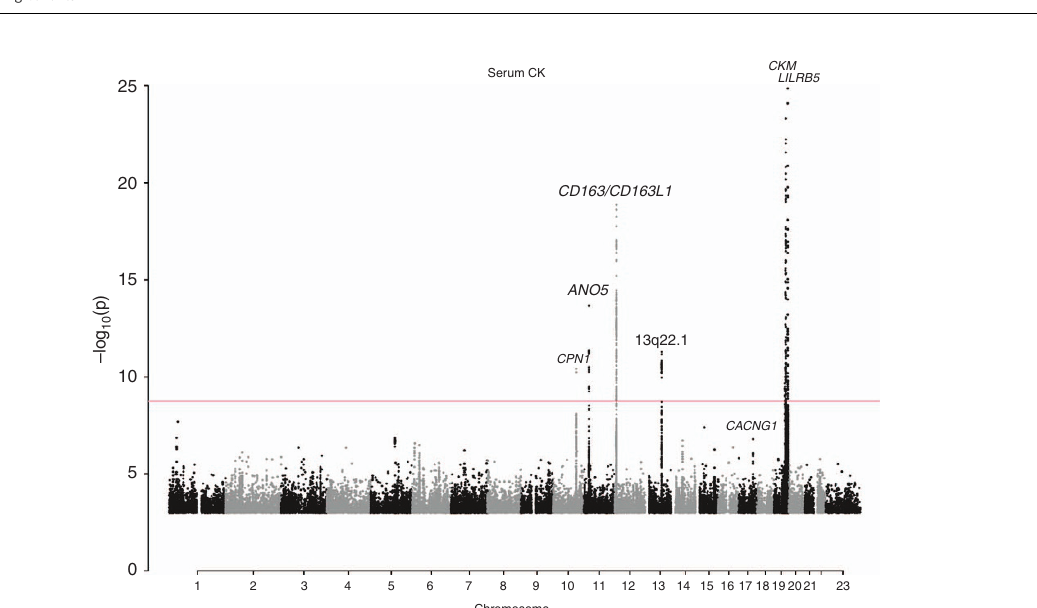
Figure 1 | Manhattan plot showing the seven loci harbouring genome-wide significant signals influencing serum CK levels in the Icelandic population. Variants are plotted by chromosomal position ( x axis) and (cid:3) log 10 P values ( y axis). P values above 1 (cid:2) 10 (cid:3) 25 are represented. Two loci ( CKM and LILRB5 ) harbour variants with P values below this cutoff (rs11559024: P ¼ 1.8 (cid:2) 10 (cid:3) 115 ; rs12975366: P ¼ 6.5 (cid:2) 10 (cid:3) 44 and rs393600: P ¼ 1.4 (cid:2) 10 (cid:3) 33 ). The red line indicates the threshold for genome-wide significance, determined by the number of tests performed ( P ¼ 0.05/28.3 million ¼ 1.8 (cid:2) 10 (cid:3) 9 ).